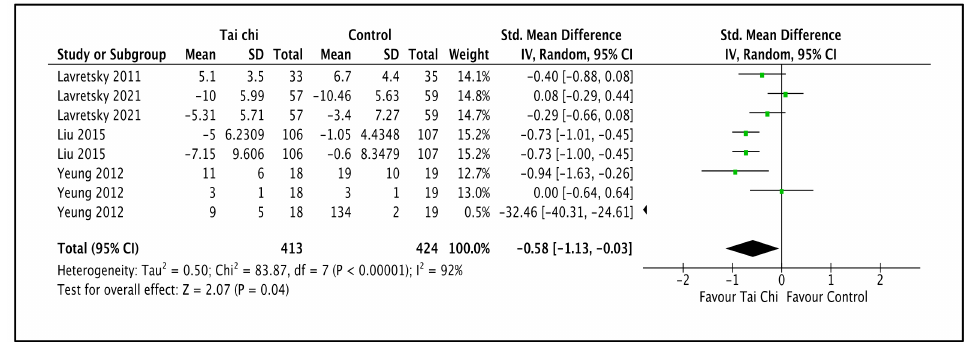
Figure 4. Forest plot provided for comparison of the combinations of Tai Chi and antidepressants versus standard antidepressants for the depressive level outcome [44,45,49,50]. Note: Line indi- cates confidence interval and the green square indicates effect estimate. Black diamond indicates cumulative effect and its confidence